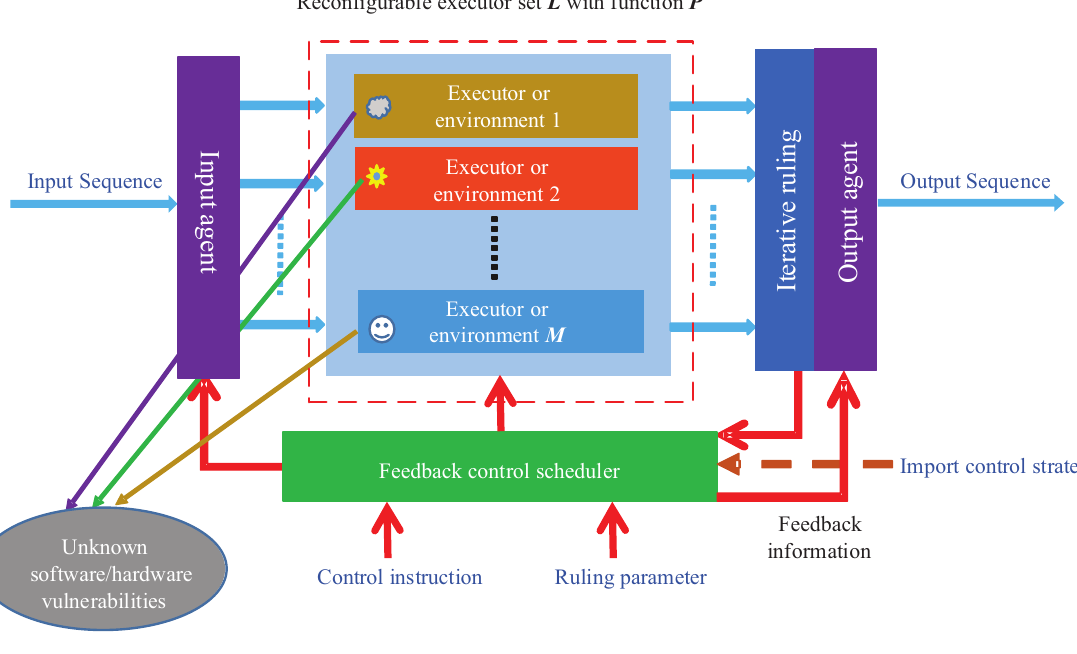
Figure 3. Logical expression of the DHR